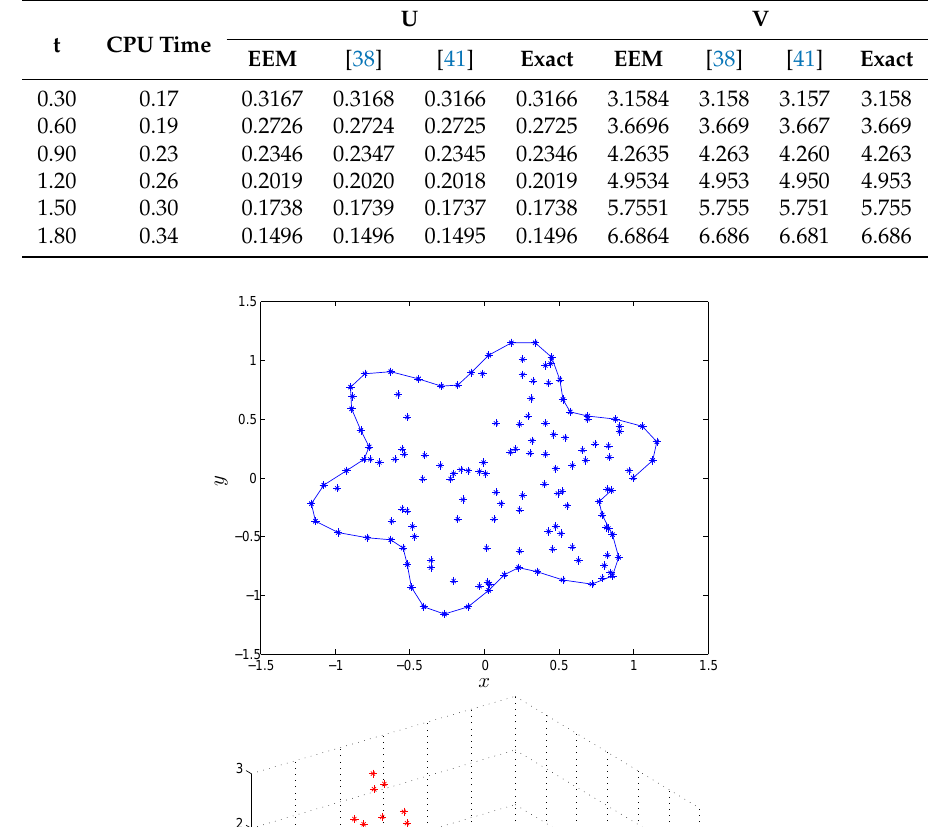
Table 11. Comparisons between the results obtained by the LMM with those adapted from [38,41] using GA RBF at point ( 0.40,0.60 ) for Test Problem 9.